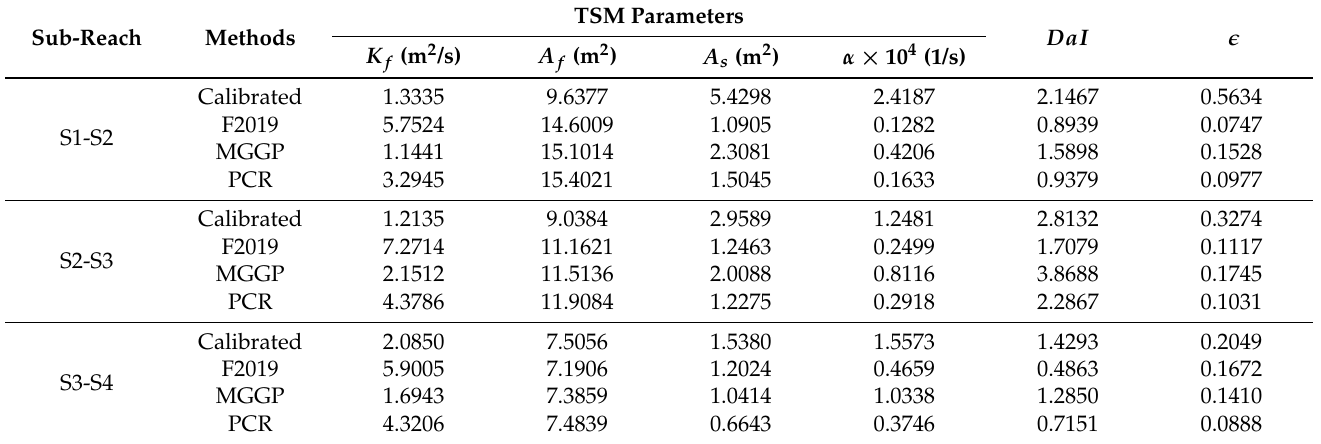
Table 5. Estimated TSM parameter values from the breaktrhough curves of Cheongmi Creek experiment. Sub-Reach